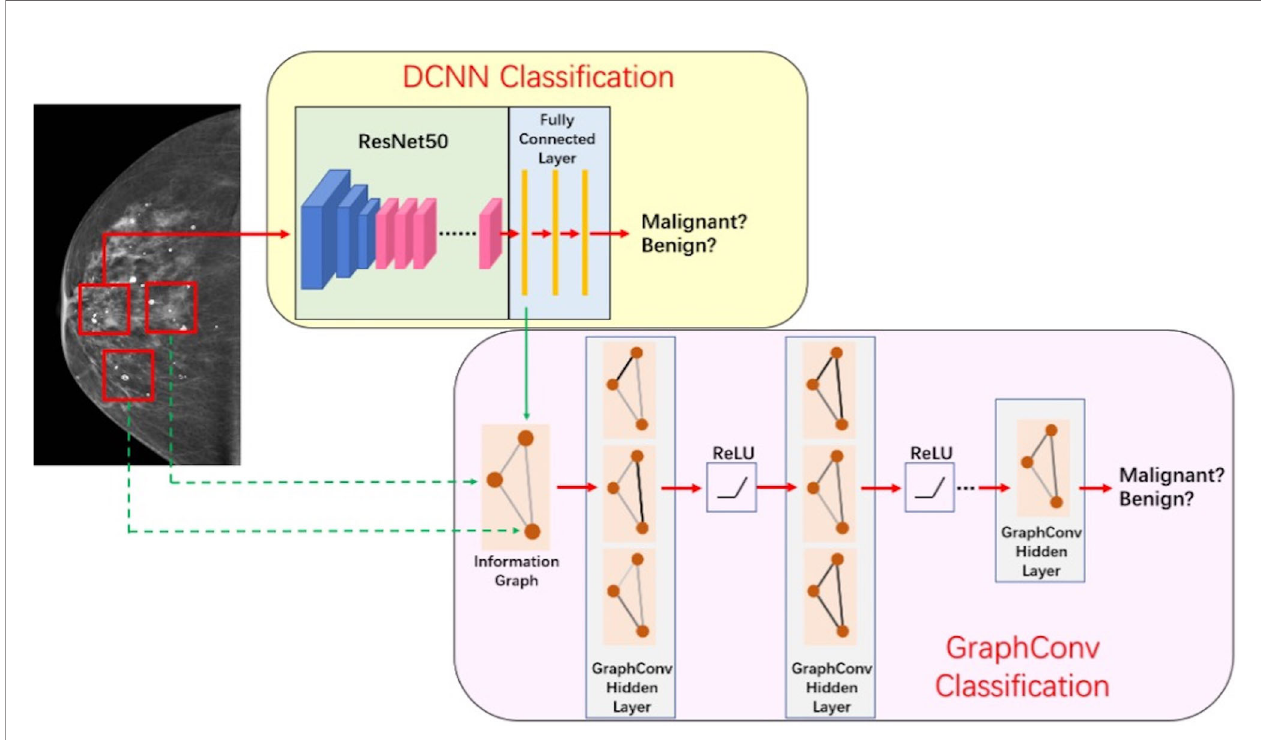
FIGURE 3 | Illustration of the network structure used for classi fi cation.